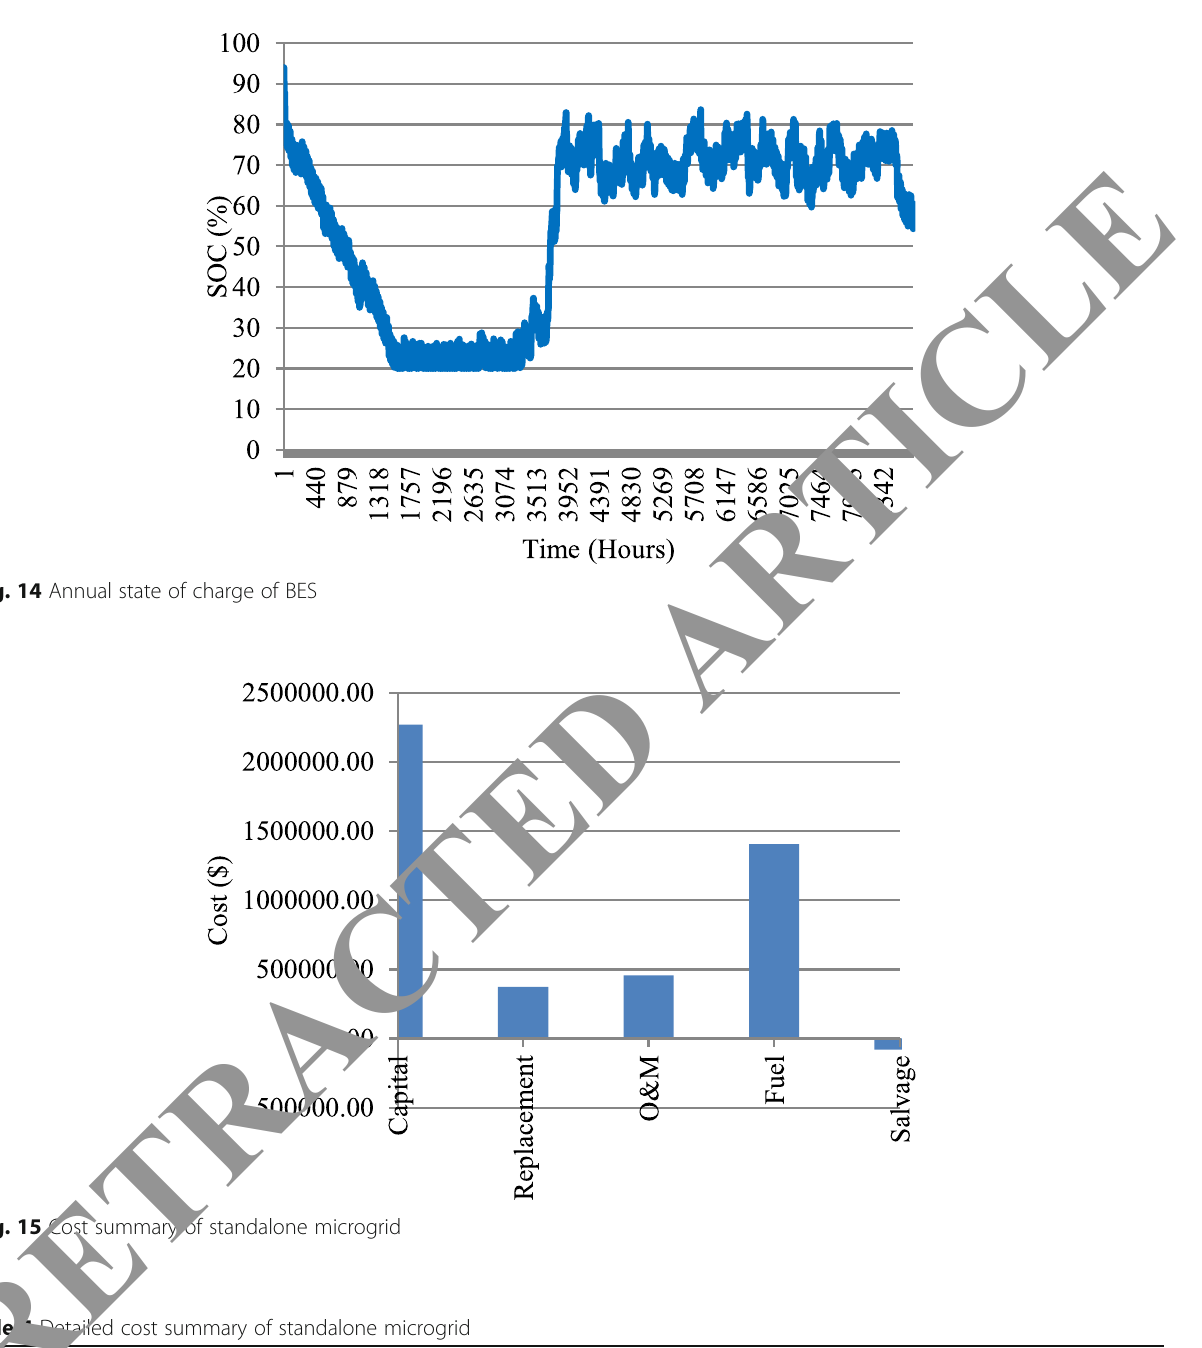
Fig. 14 Annual state of charge of BES